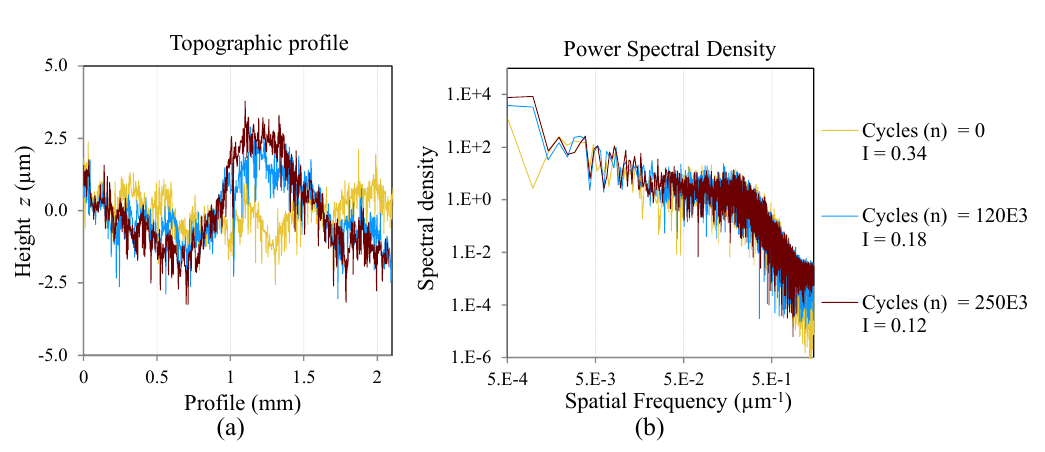
Figure 10. Evolution of the I ‐ Factor of all the coupons cycled with CAL. The shown I ‐ Factor for each coupon is the mean value of the areas of inspection; ( a ) Evolution through the fatigue cycles; ( b ) Relation between the evolution of the stiffness degradation and the evolution of I ‐ Factor.